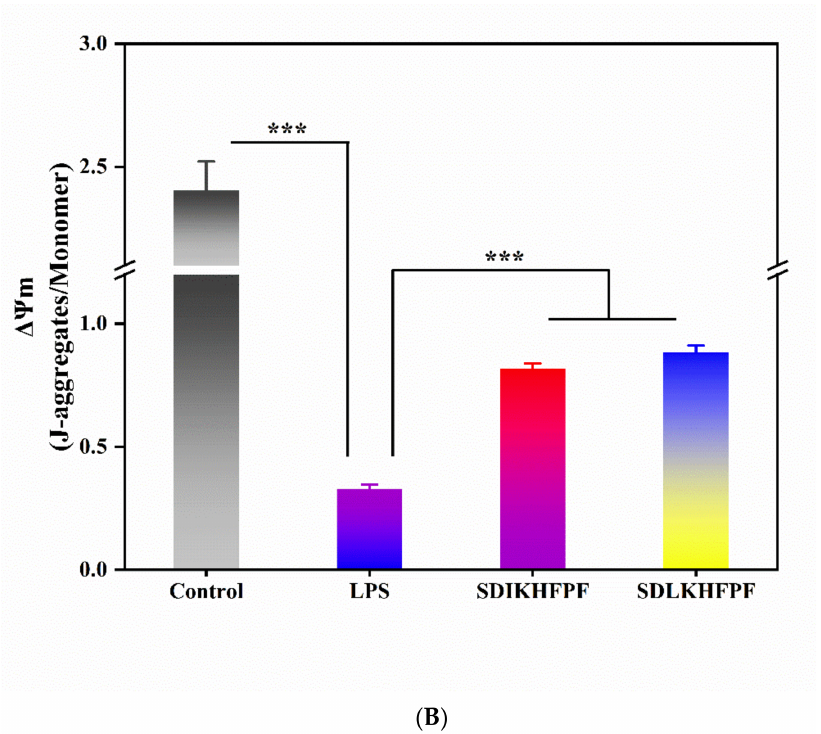
Figure 4. ( A ) Fluorescence microscopy imaging of the mitochondrial membrane potential for RAW264.7 macrophages stained by JC-1. ( B ) The mean fluorescence density of red/green fluorescence intensity ratio. Data were represented as mean ± SD ( n = 3), ***: p <